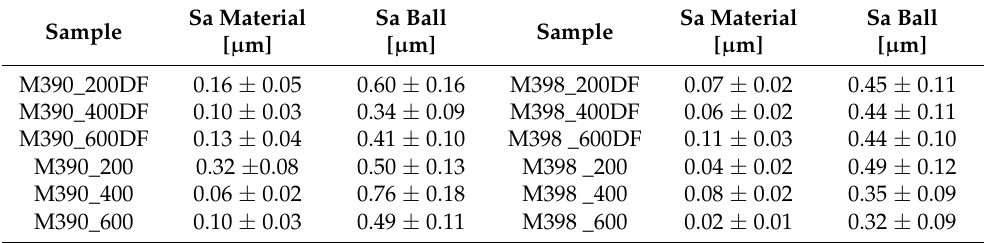
Table 4. Comparison of Sa parameter of materials, M390 and M398, and ceramic balls, Al 2 O 3 .